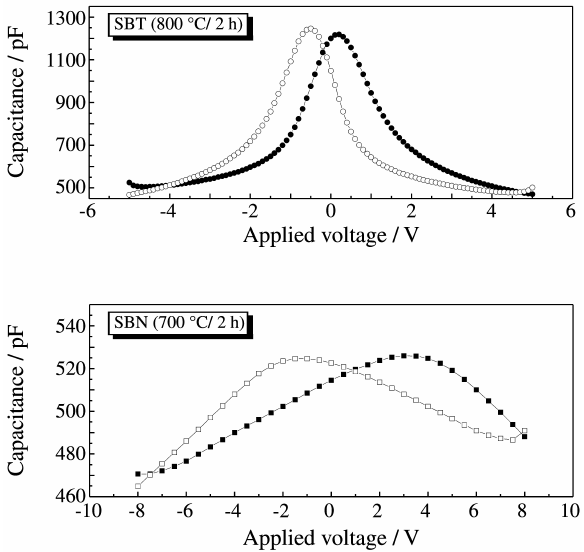
Figure 6. C-V curves of SBN and SBT films.